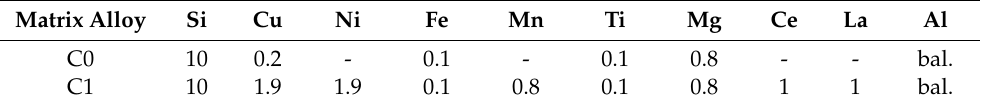
Table 1. Chemical composition of matrix alloys [wt.%]. Matrix